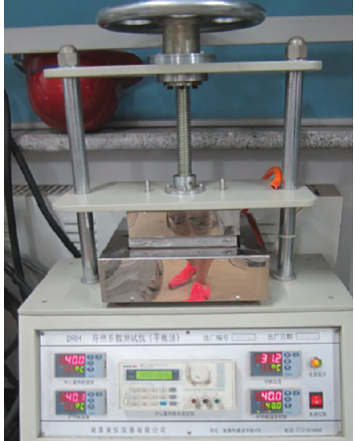
Figure 14: DRH-guarded hot plate thermal conductivity tester.